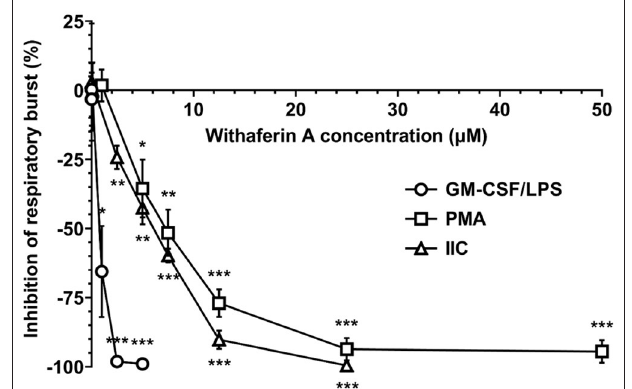
FIGURE 3 | Withaferin A inhibits neutrophil respiratory burst stimulated by GM-CSF/LPS, PMA, and insoluble immune complexes (IIC). Mean (SEM) percent difference in mean luminescence relative to VC in WFA-treated equine neutrophils post-stimulation with GM-CSF/LPS (circles, 40min, n = 6 horses), PMA (squares, 60min, n = 5 horses), or IIC (diamonds, 30min, n = 5 horses). Luminol-enhanced chemiluminescence detection of reactive oxygen species. One-way repeated measures ANOVA (Holm-Sidak multiple comparison testing); * p < 0.05, ** p < 0.01, *** p < 0.001, as compared to 0% difference from VC.